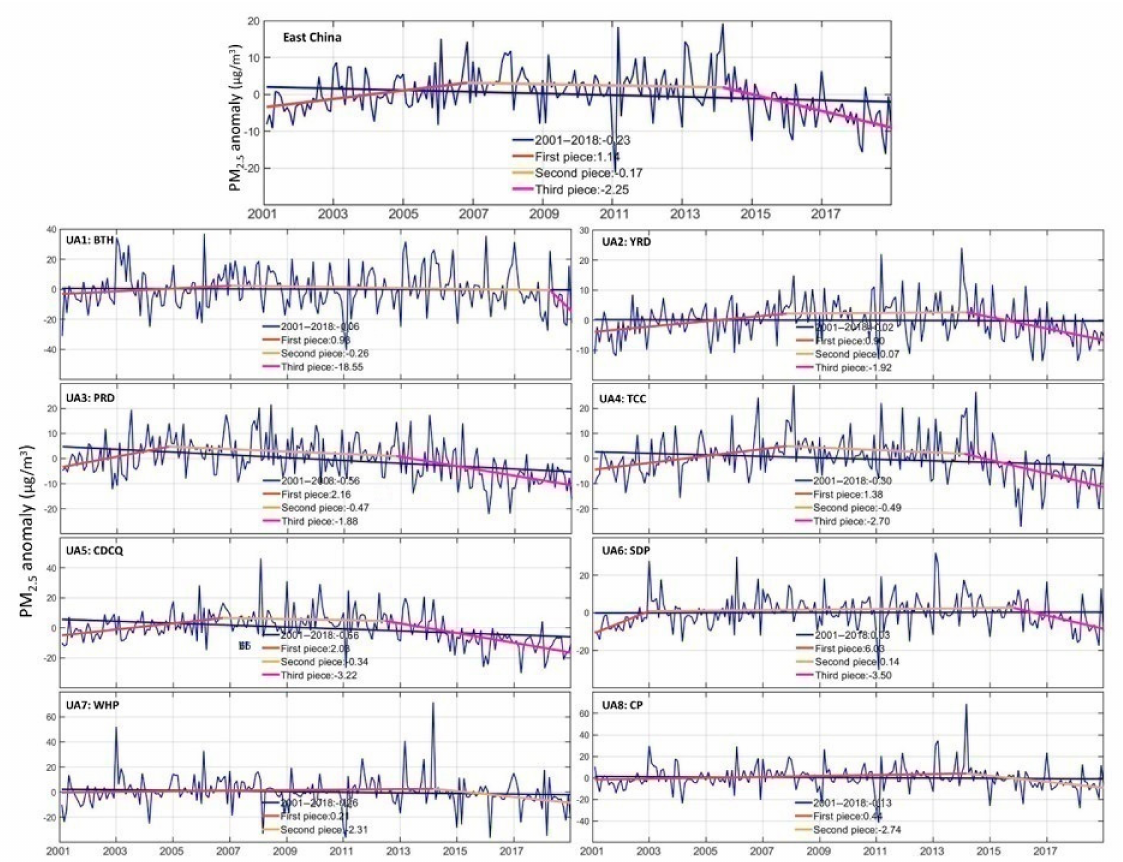
Figure 4. Monthly time series of population-weighted mean PM 2.5 predictions from 2001 to 2018 in the entire study region and eight urban agglomerations with corresponding piecewise linear trends. The grid population data were from